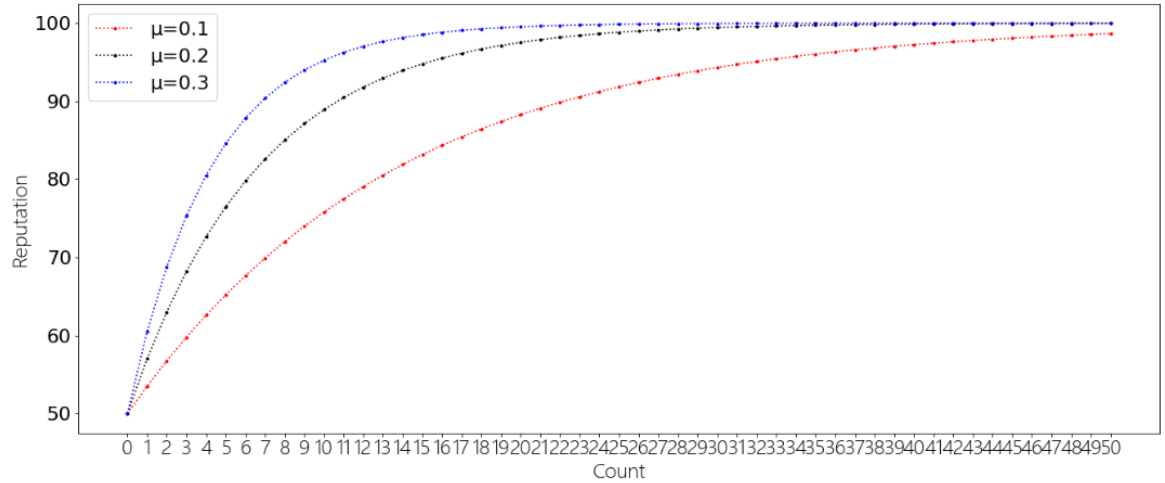
Figure 7. The increase in reputation under different μ .